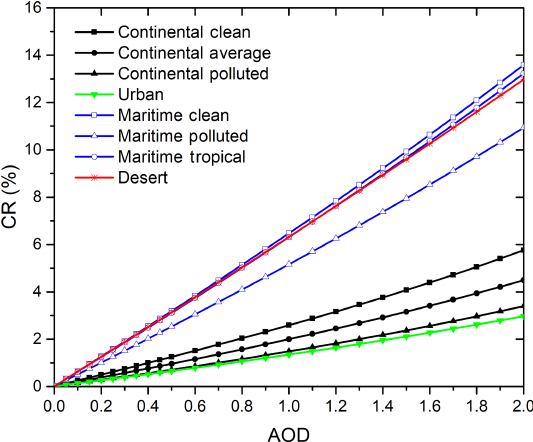
Figure 6. Simulations of CR (%) for SZA 30 ◦ at sea level for AOD values between 0 and 2, at 500nm, for different types of aerosols for FOV of 5 ◦